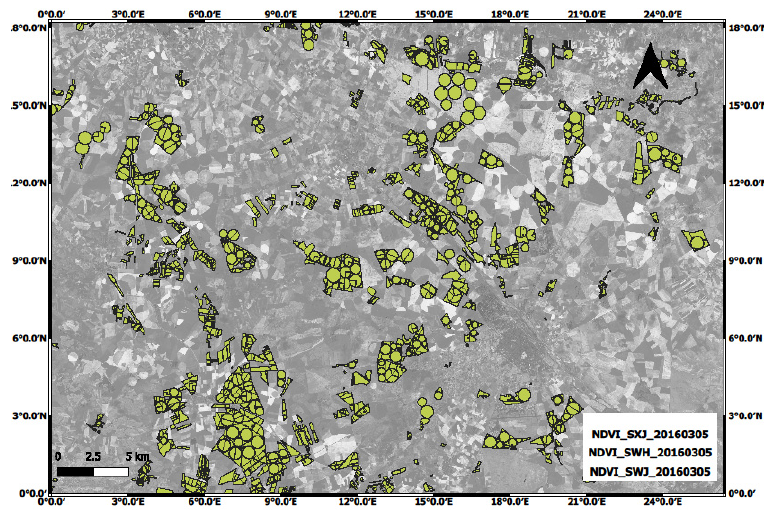
Figure 3. A zoomed normalized difference vegetation index (NDVI) scene composed by three Sentinel-2A tiles SXJ, SWJ, and SWH (obtained in 2016.03.05) over the study